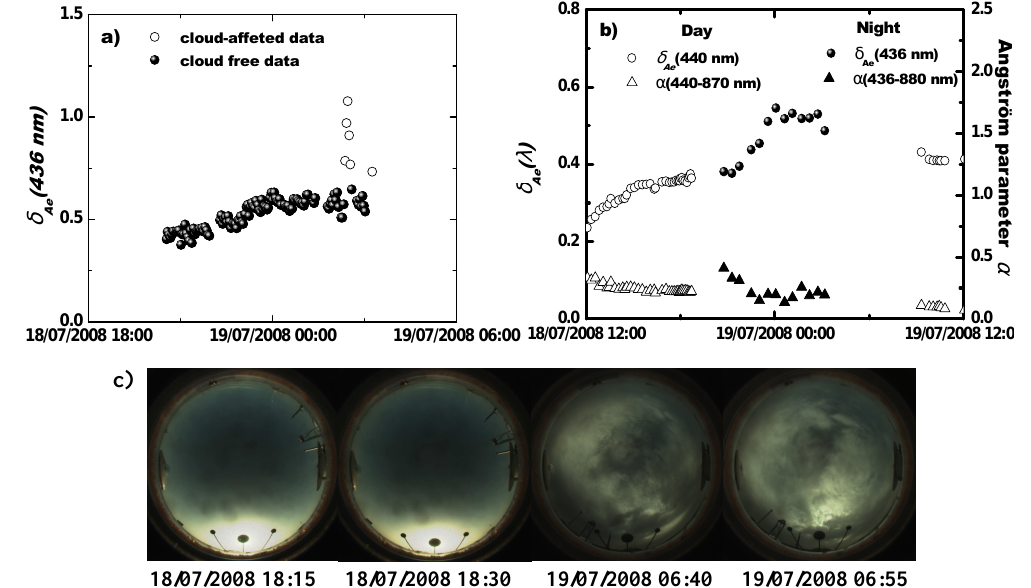
Fig. 7. (a) Time evolution of aerosol optical depth during a Saharan dust outbreak over the city of Granada during the night 18–19 July 2008. (b) Day-and-night time evolutions of aerosol optical depth and Angstr¨om parameter α from 18 to 19 July 2008, after applying the cloud screening algorithm presented in this work to the nighttime data. (c) All-sky images during late 18 and early 19 July 2008 (times expressed in UTC).